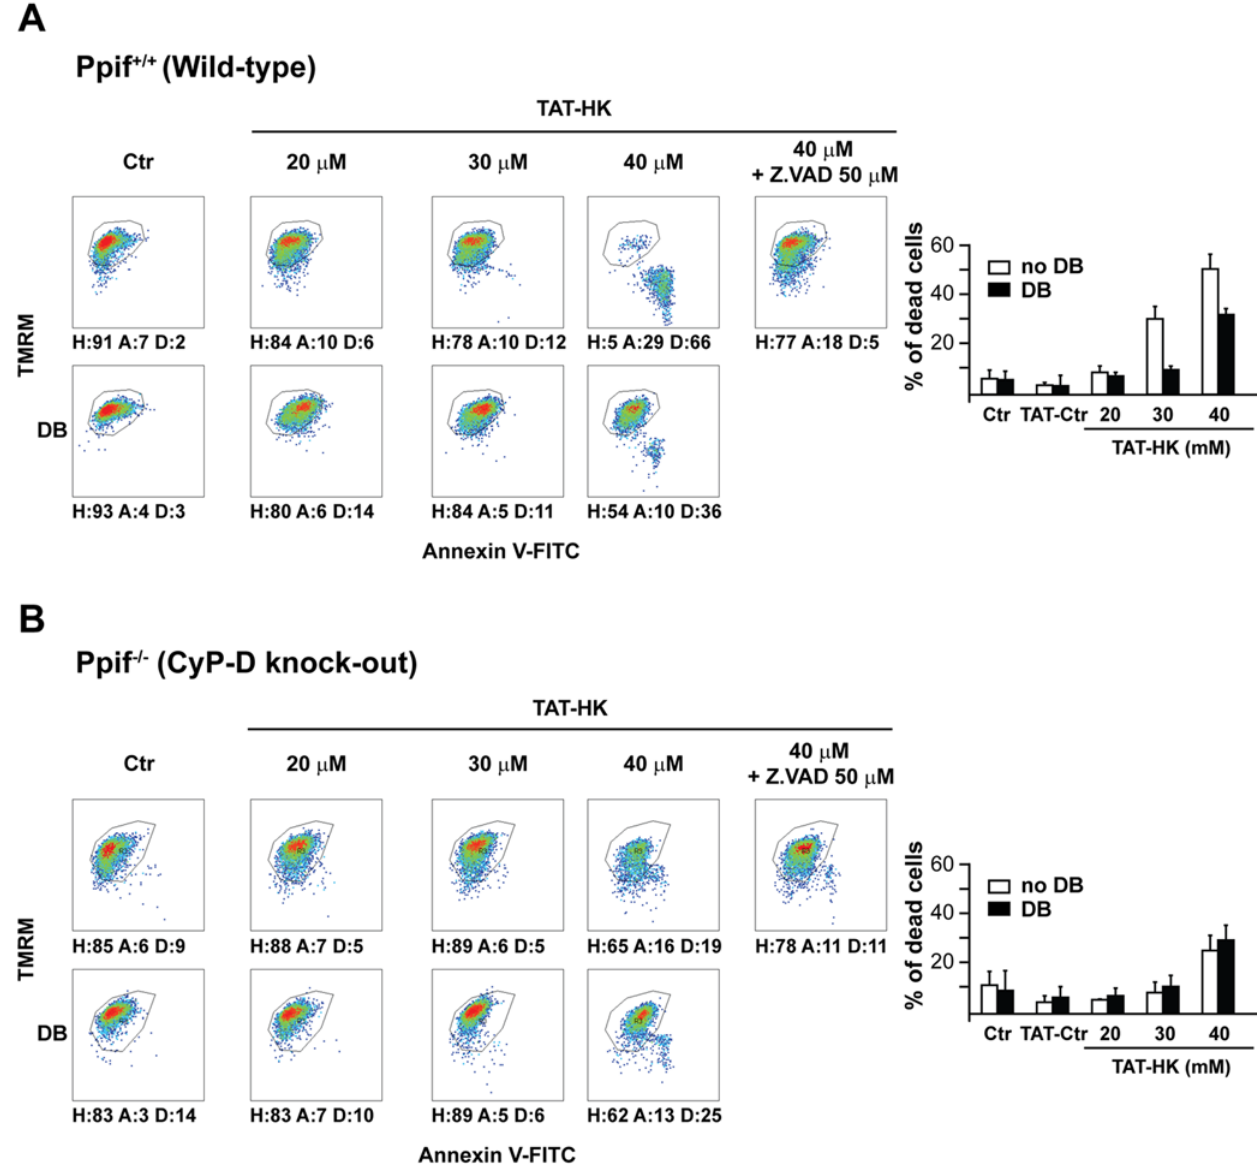
Figure 3. CyP-D modulates apoptosis triggered by detachment of HK II from mitochondria. (A, B) Output of multiparametric FACS analyses show apoptosis induction in fibroblasts obtained either from wild-type mice (A) or from mice in which the Ppif gene encoding for CyP-D